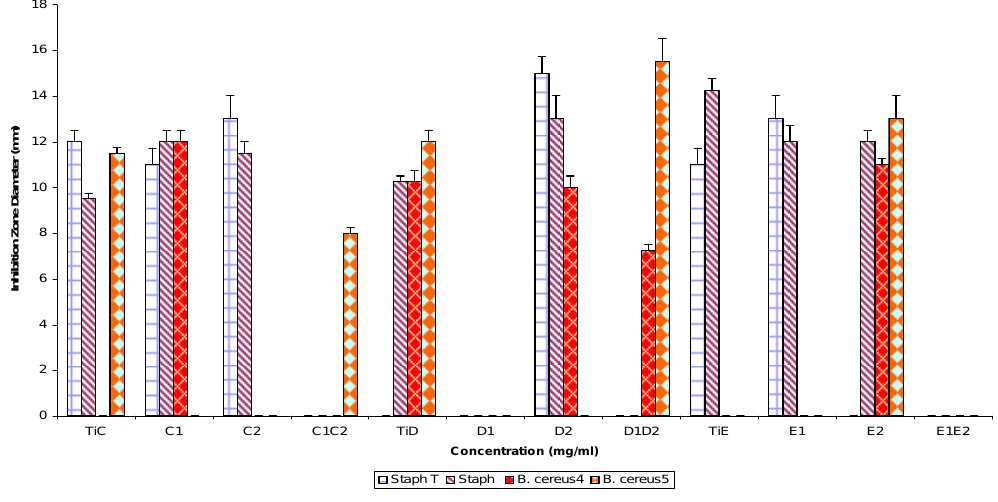
Figure 6. Antibacterial susceptibility pattern of Gram positive bacterial test strains to fraction TiC, TiD and TiE, refraction products singly and in